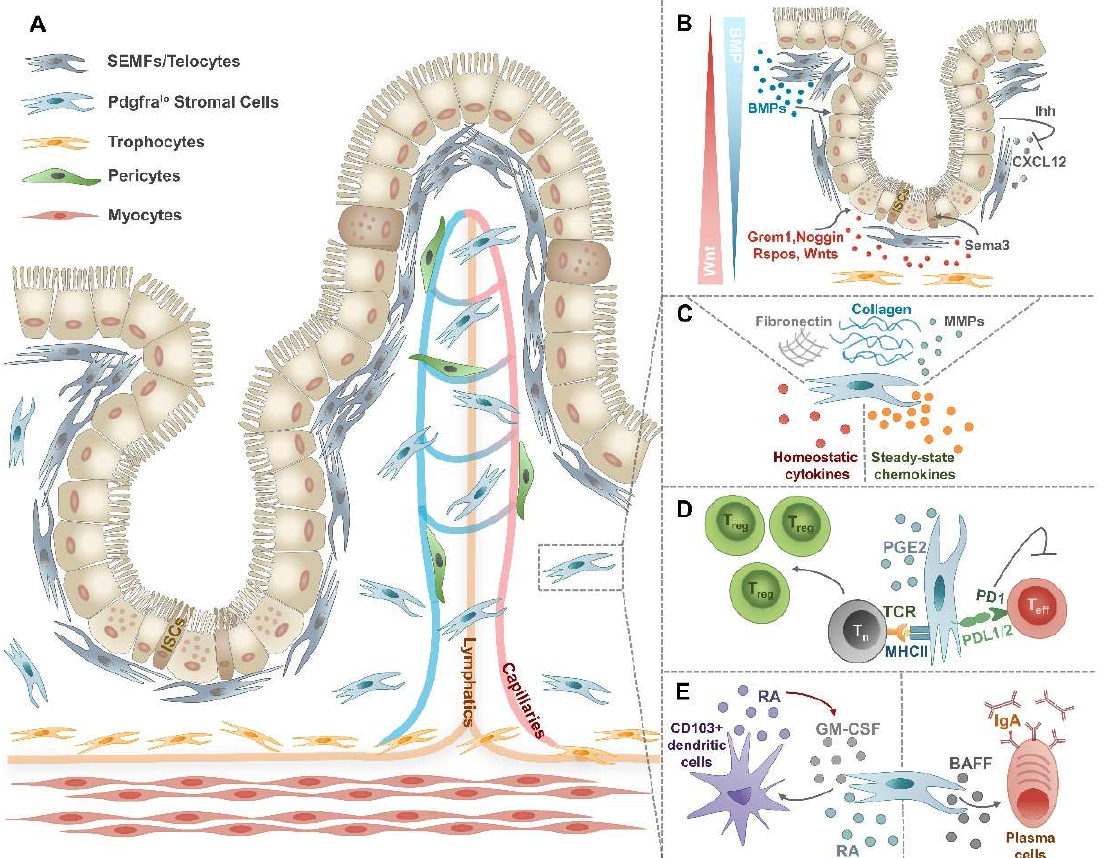
Figure 1. Heterogeneity and functions of steady-state IMCs. ( A ) In the lamina propria and the muscularis mucosae distinct subsets of IMCs can be found. Directly underneath the epithelium, SEMFs or telocytes form an envelope. Pdgfra lo stromal cells are dispersed along the crypt–villus length. Close to the muscularis externa and below the crypts, trophocytes form a stripe. Pericytes are found in the perivascular area. ( B ) SEMFs and trophocytes play a critical role in creating a niche for ISCs by the secretion of Wnt and BMPs. ( C ) Under steady-state conditions, IMCs not only excel in producing ECM components and matrix remodeling enzymes but also secrete a wide array of immunomodulatory cytokines and chemokines. ( D ) By the expression of PDL1/2 and MHC-II molecules, IMCs play a critical role in the maintenance of intestinal tolerance. ( E ) IMCs may induce tolerogenic CD103 + dendritic cells and IgA + plasma cells, both of which contribute to intestinal homeostasis.